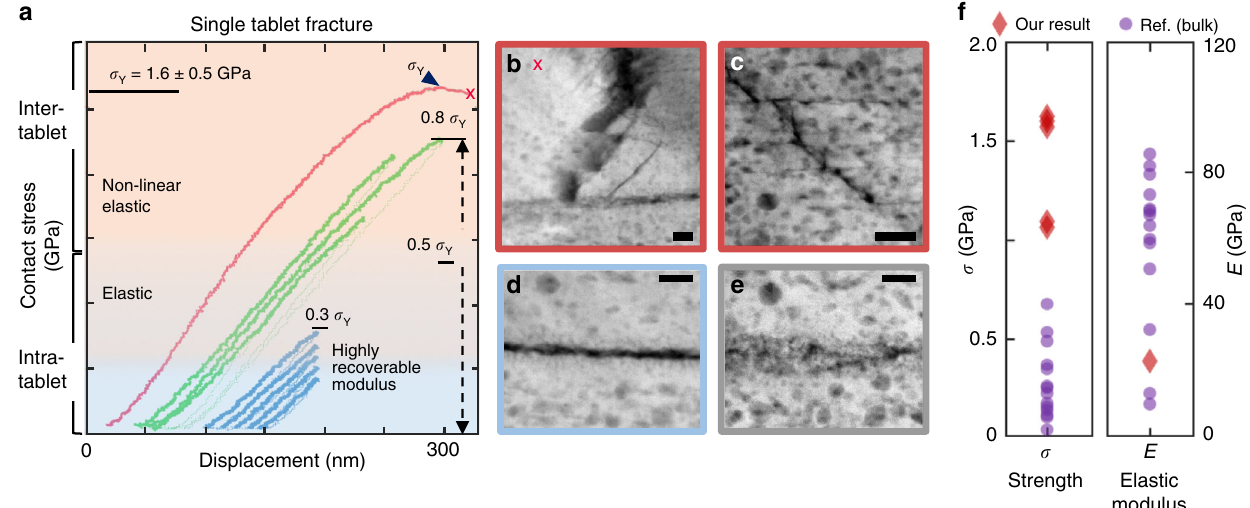
Fig. 3 Recoverable mechanical strength of nacre and crack blunting within and between tablets. a Nine consecutive in situ TEM compression tests on the same nacreous tablet. Three different colors correspond to different contact areas during the series of the compressions. Stage drift caused changes to contact area between indentations. b ADF STEM images after the series of the indentation tests showing a crack blunted by an organic boundary. c ADF STEM image shows crack formed within tablet and blunted by an organic inclusion. d , e ADF STEM images of nacre tablet compressed by 47 µ N (55% of σ — after deformation, nacre still preserves both its initial strength Yield ), corresponding to the non-linear elastic regime; structure remains fully recoverable and structure. f Strength and elastic modulus of nacre from contact stress in nanoindentation on the thin cross-sectional specimen in this study and various types of testing — microscale tribology, tensile, compression, and bending — on bulk specimens in previous reports. Scale bar 50